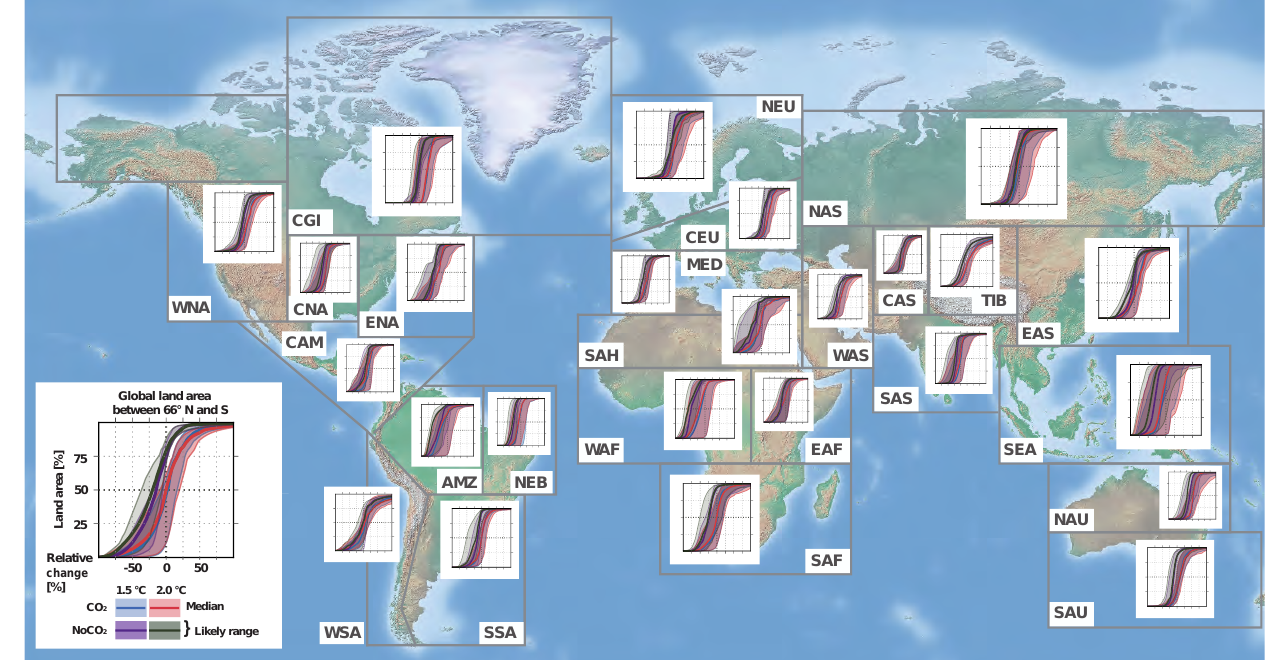
Figure 9. Same as Fig. 2 but for changes in wheat yields. Changes are given relative to the 1986–2005 reference period and ensemble projections excluding the effect of CO 2 -fertilization are shown separately. The CDFs are derived only over the present-day growing areas of the